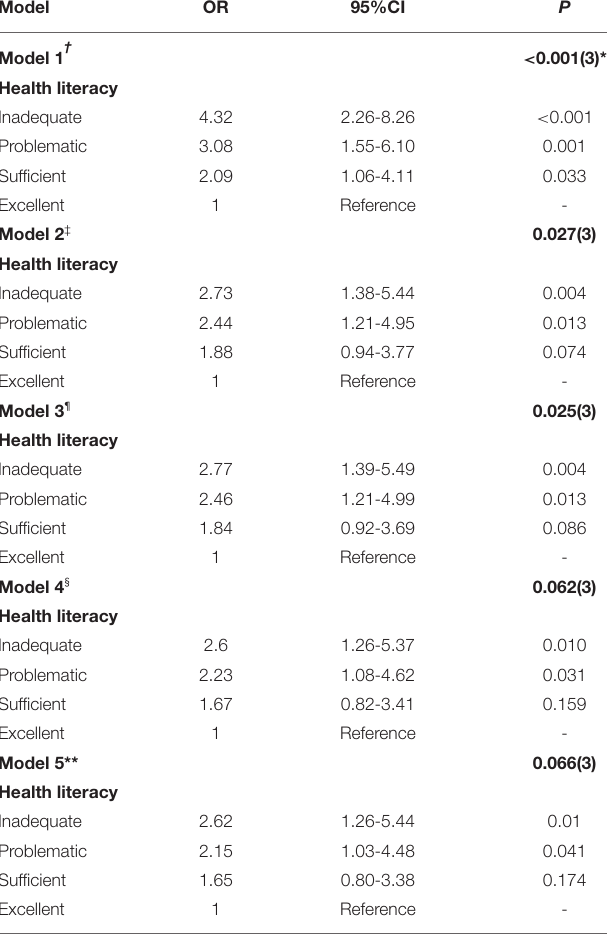
TABLE 4 | Association of HL with blood glucose level; multivariable-adjusted odds ratios (ORs: diabetes vs. no diabetes) from binary logistic regression. Model OR